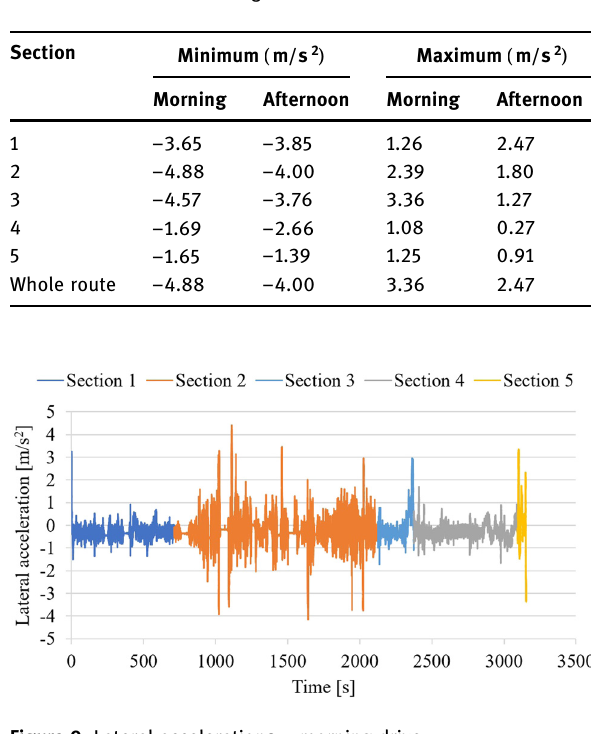
Figure 9: Lateral accelerations – morning drive.